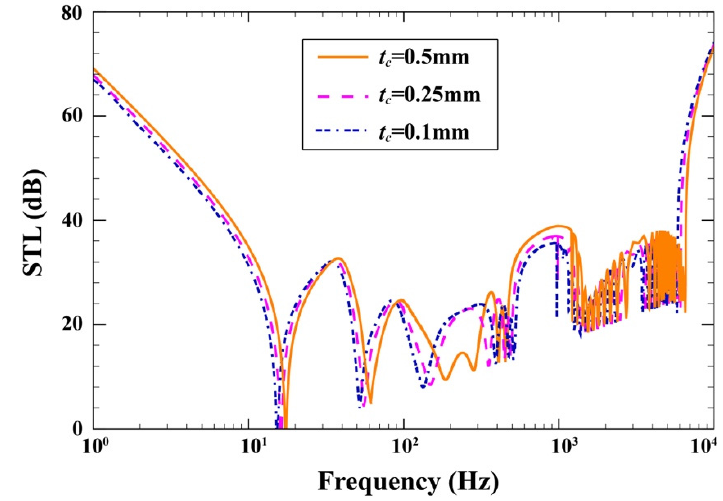
Figure 10. Effect of the wall thickness of honeycomb cell on the changes of STL.